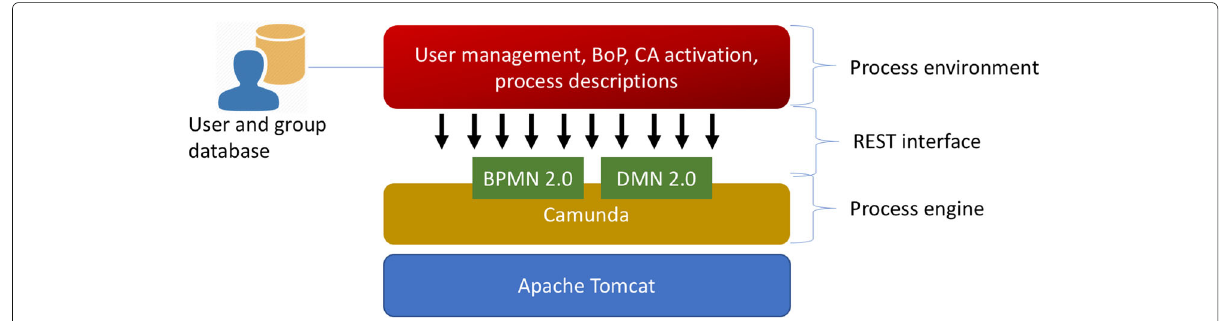
Fig. 13 Process Platform Stack